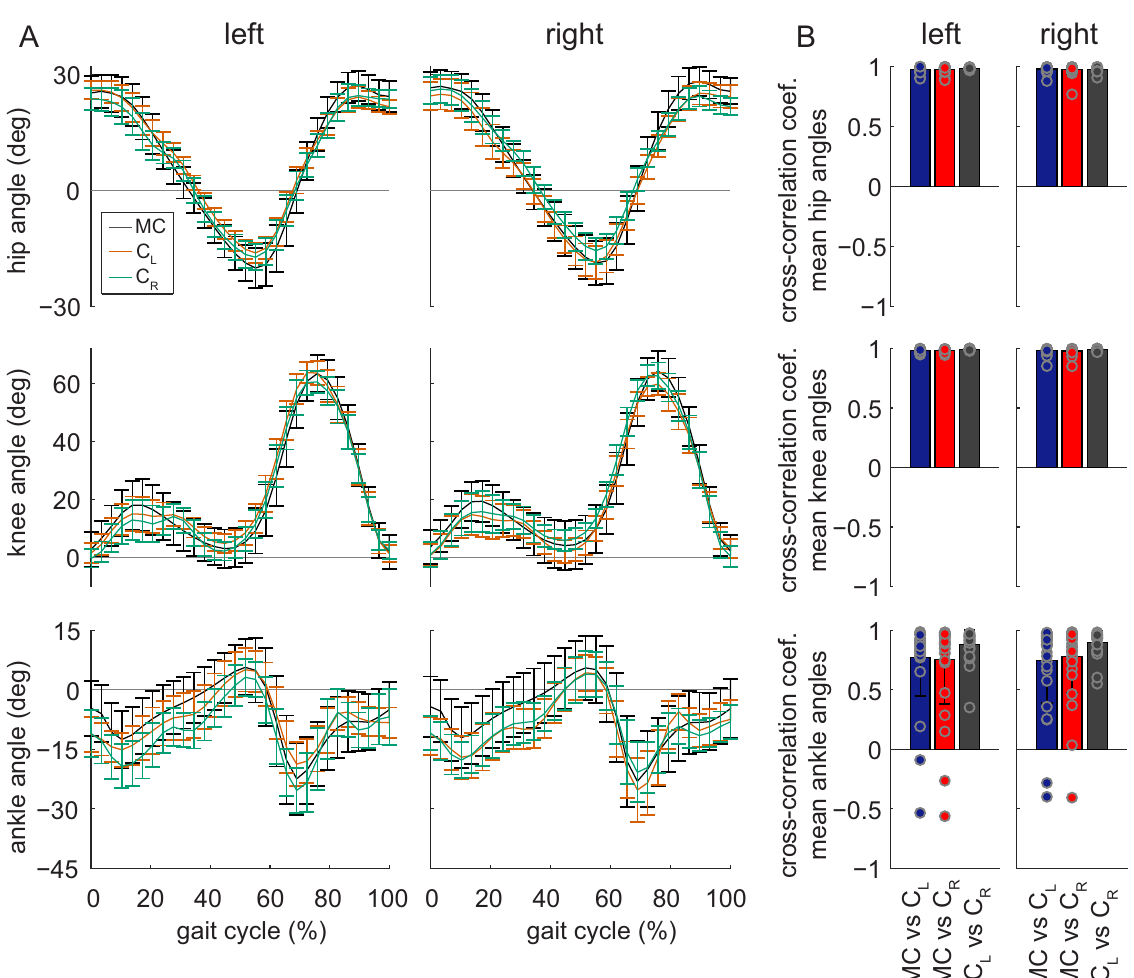
Fig 7. Sagittal plane hip, knee and ankle angles. A) Group mean ± SD ensemble sagittal left and right joint angles for the three measurement systems: motion capture (MC), OpenPose left-side view (C L ) and right-side view (C R ). For all angles, positive values indicate flexion (or dorsiflexion) and negative values indicate extension (or plantarflexion). B) Cross-correlation coefficients at time lag zero (individual data, group means and SD) for individual participant mean joint angle profiles between measurement systems.